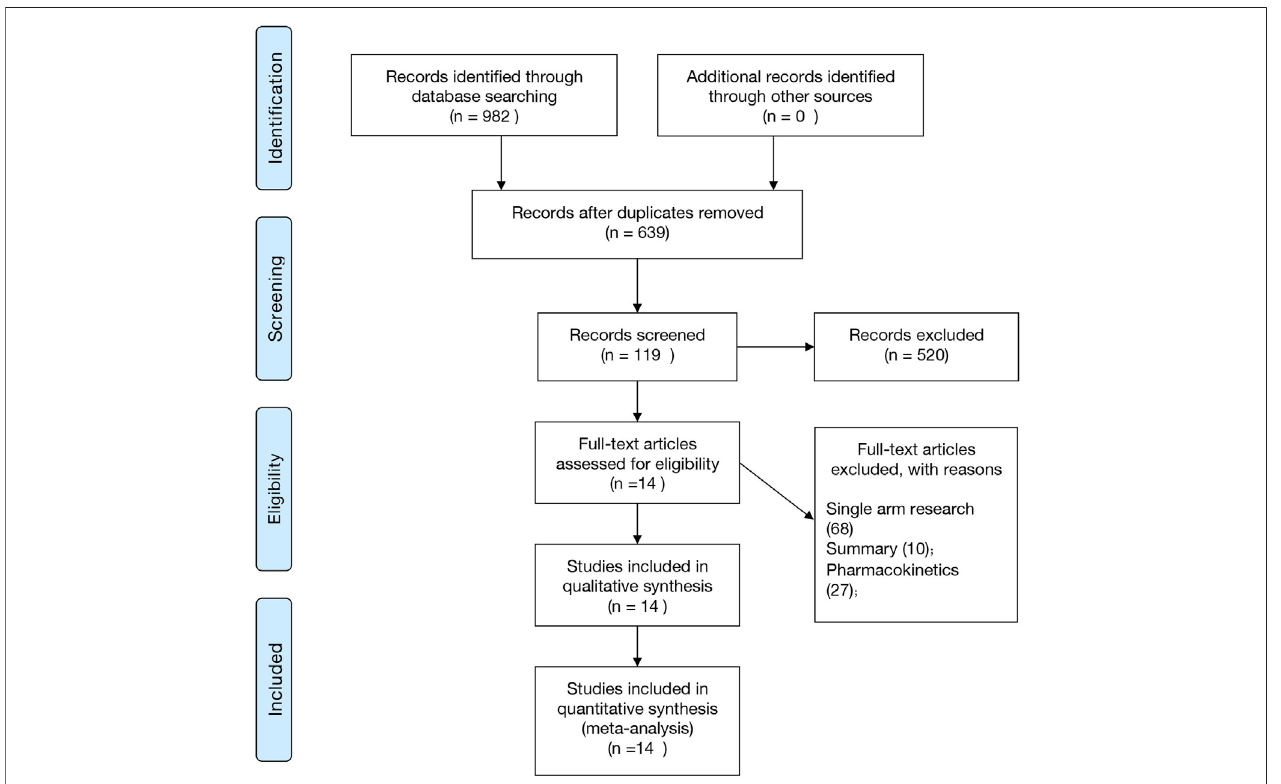
FIGURE 1 | Retrieval selection